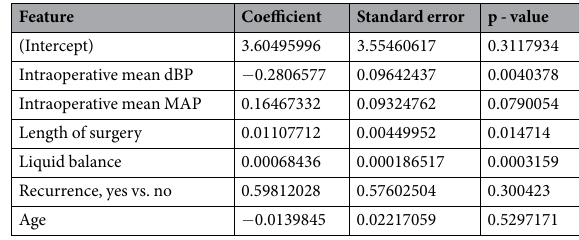
Table 3. Rank regression model for infarct volume as dependent